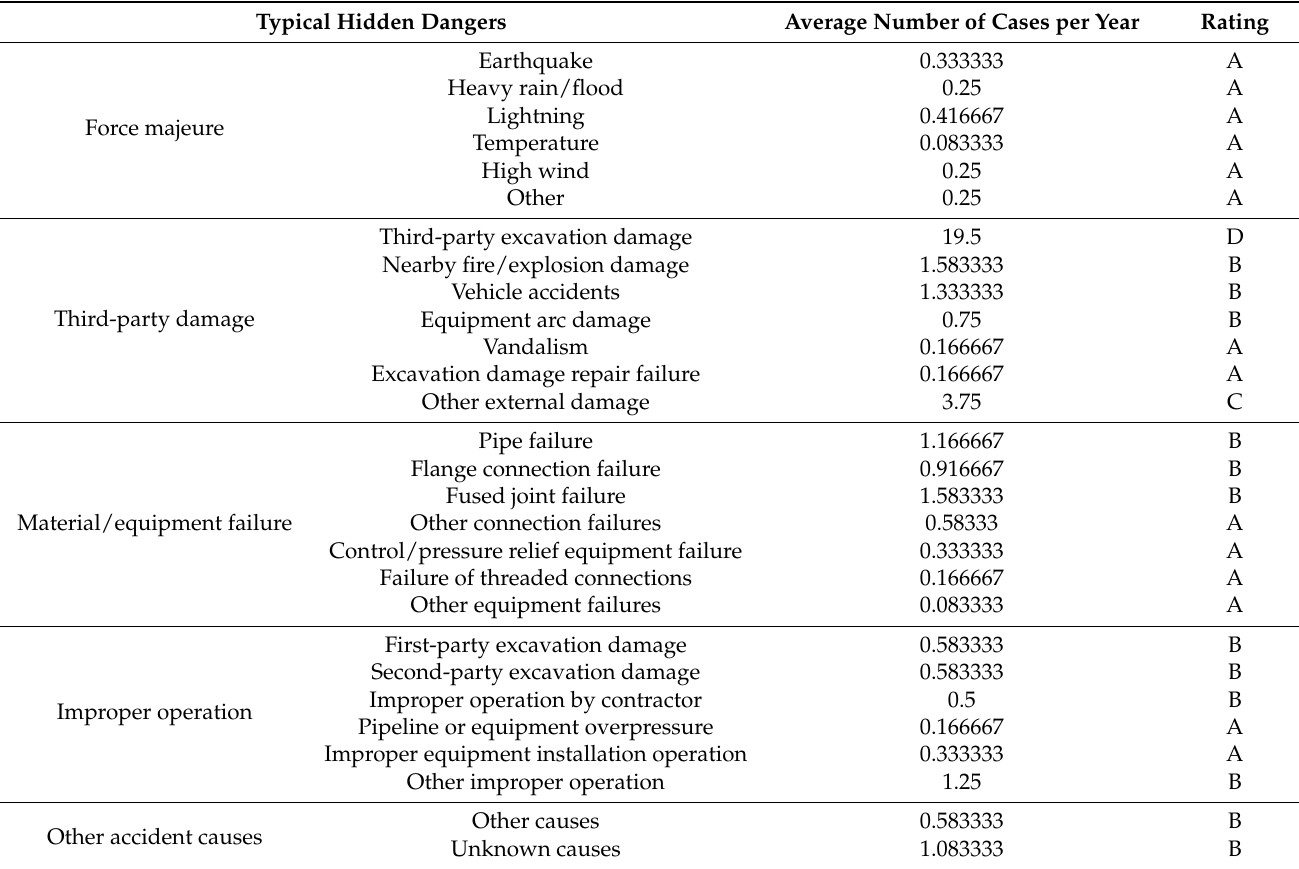
Table 4. Urban gas PE pipeline database possibility rating for hidden